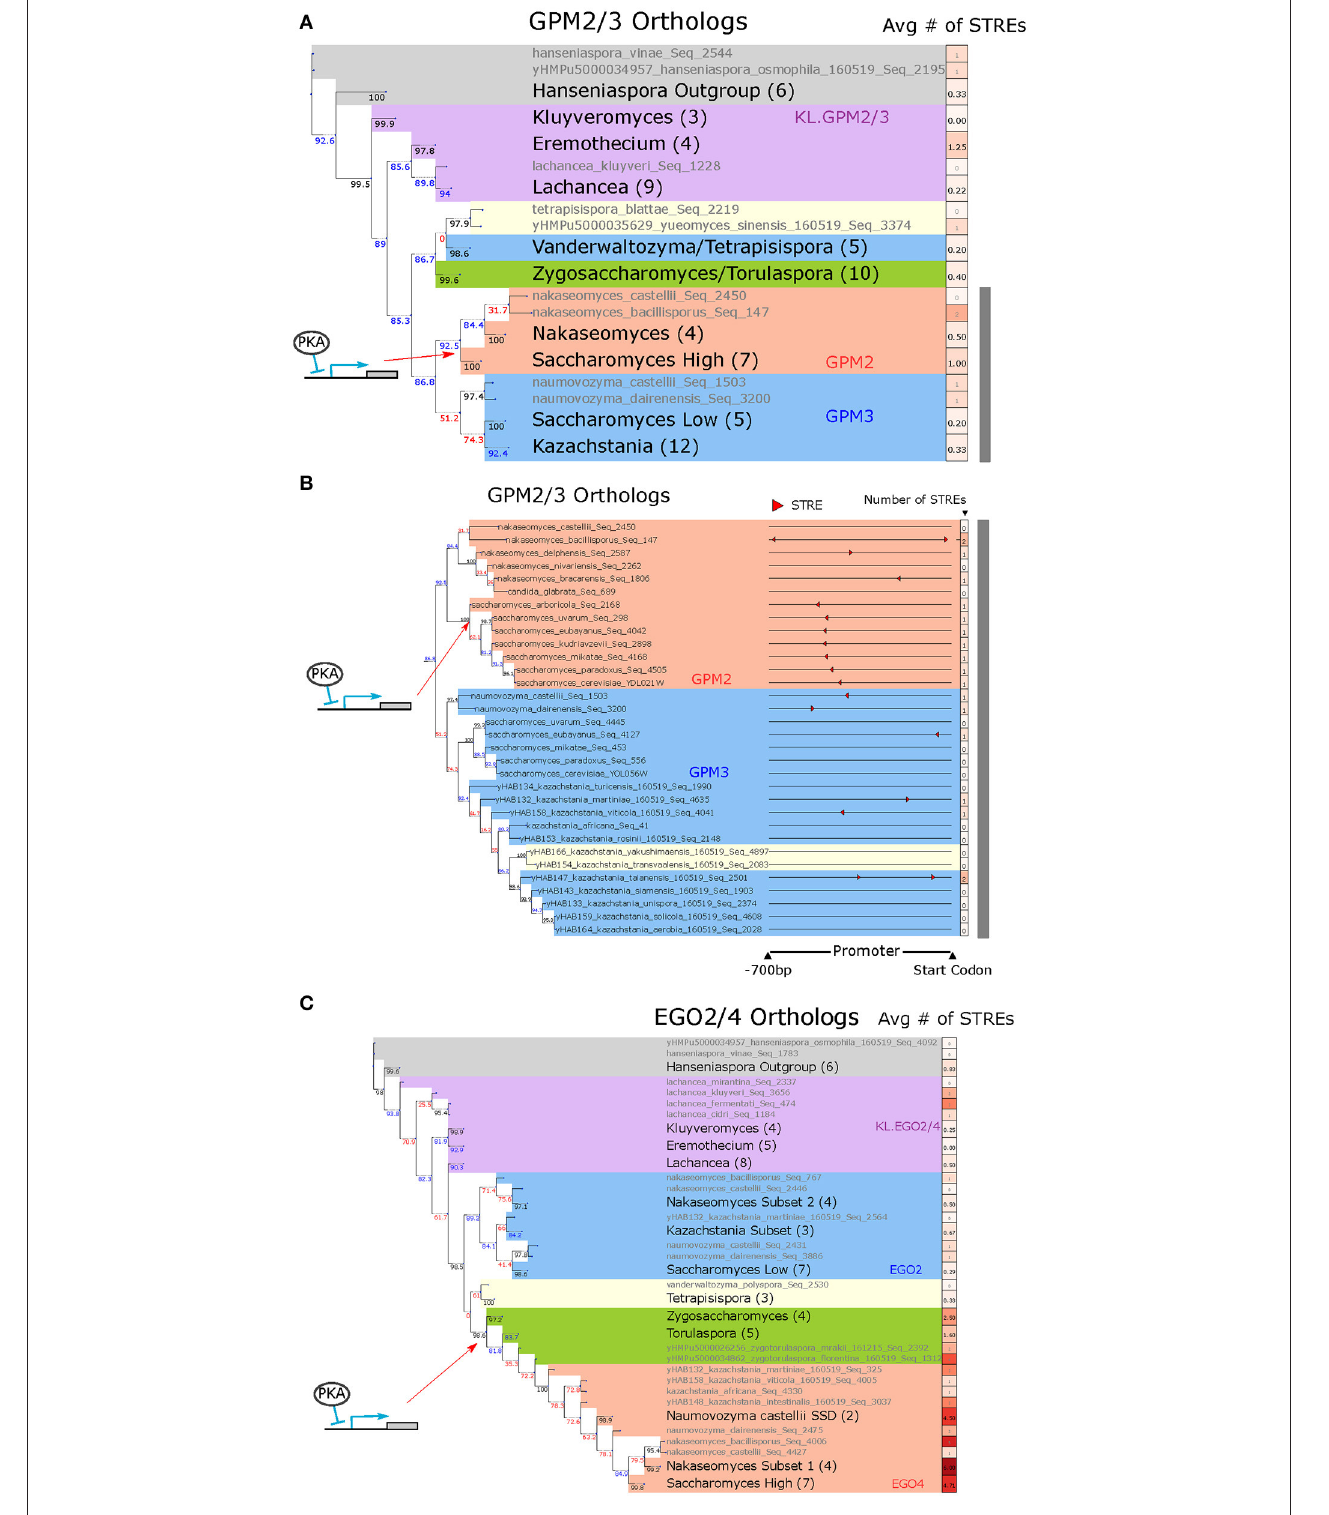
FIGURE 6 | GPM2/3 are an example of a differentially induced ohnologs pair in which the STRE arose in the promoter of the DE PKA high-LFC ohnolog following the WGH. EGO2/4 are an example of a differentially induced ohnolog pair in which the STRE may have arisen in the ZT branch prior to the WGH. (A) Phylogeny of